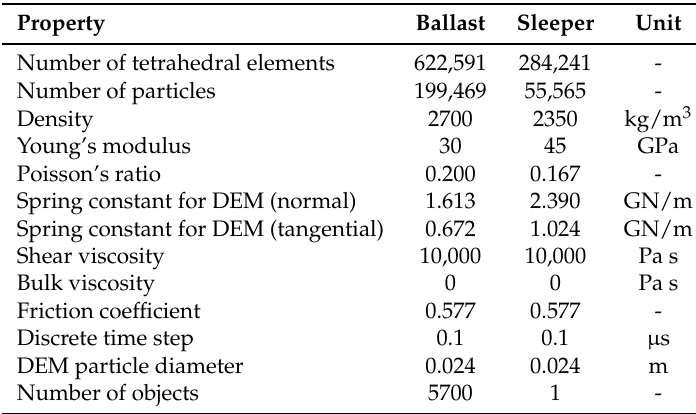
Table 1. Simulation conditions of the ballast and